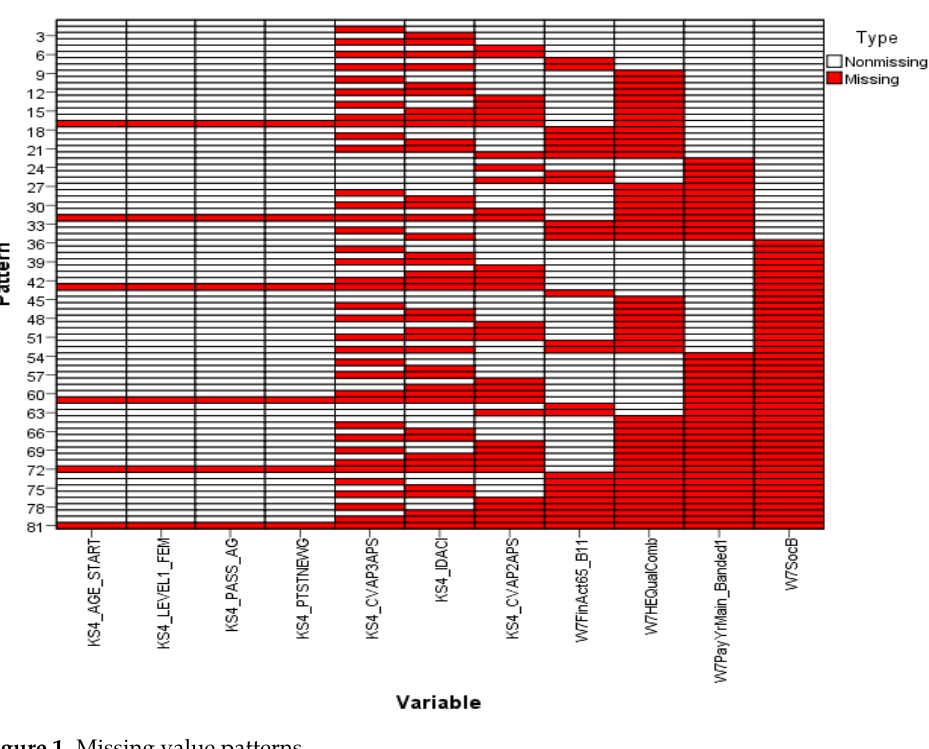
Table 1. Descriptive statistics for the observed data, the five imputed datasets and the five com- plete datasets Observed